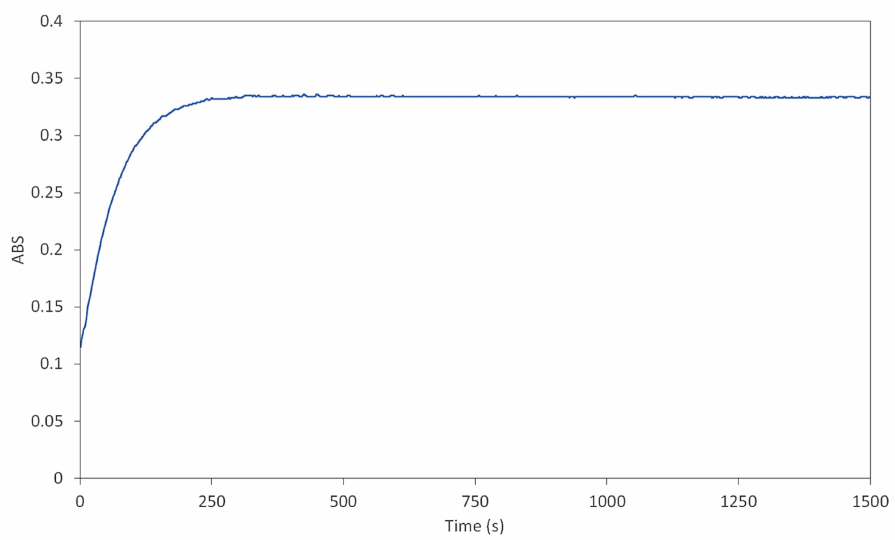
Figure 1. Absorbance vs. time of a solution of DPC and Cr(VI) at 540 nm.